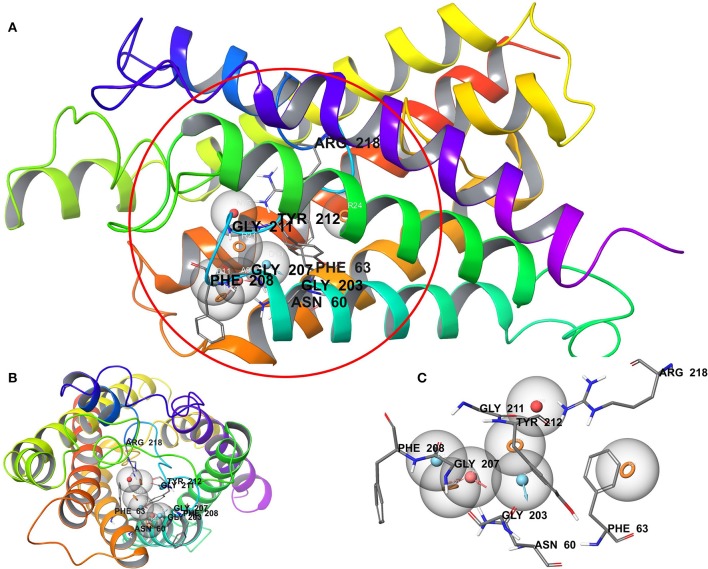
(A) Whole protein showing cavity-based pharmacophoric point; (B) top view with pharmacophoric point; (C) pharmacophoric point with label residues in the binding pocket.